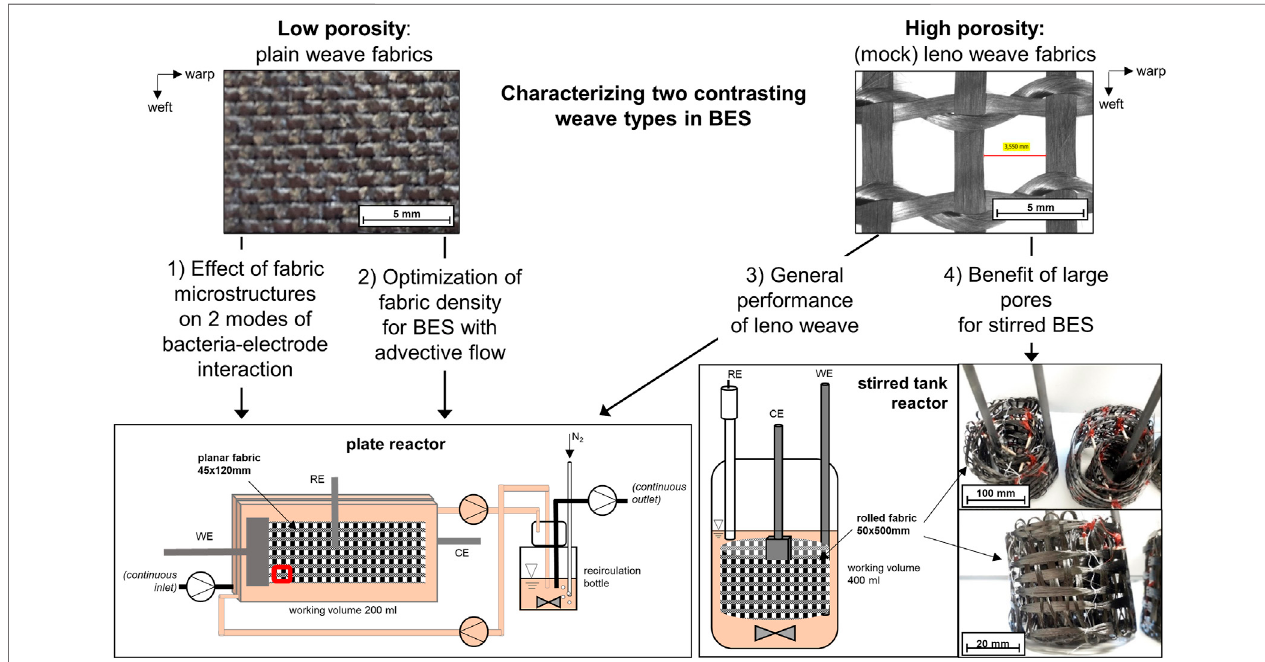
FIGURE1| Scopeofthestudyandbioelectrochemicalsetups.Thestudyevaluatestwocontrastingcarbontextileelectrodes:aplainweavefabric — oftypicallylow porosity — andalenoweavefabric,whichcanachieveinter-yarngapsatcmscale(topphotograps).Warpandweftyarndirectionareindicated.Thetwoweavetypesare characterized forapplicationsin1) BES withmainly advective fl owregimes(left,plate reactor) and 2) stirred systems (right,stirred tank reactor), whichcould bene fi tfrom fl uid fl owacrosstheelectrode.Plainfabricsareusedtoinvestigatetheimportanceofµmtopologiesfortwomodesofelectrontransferbyelectroactivebacteriaand, thefabricdensityoftheselow-porosityfabricsisexemplarilyoptimized.Lenoandmocklenofabricsareusedtodemonstratethebene fi tofhighporosityfabricsforstirred tank BES.